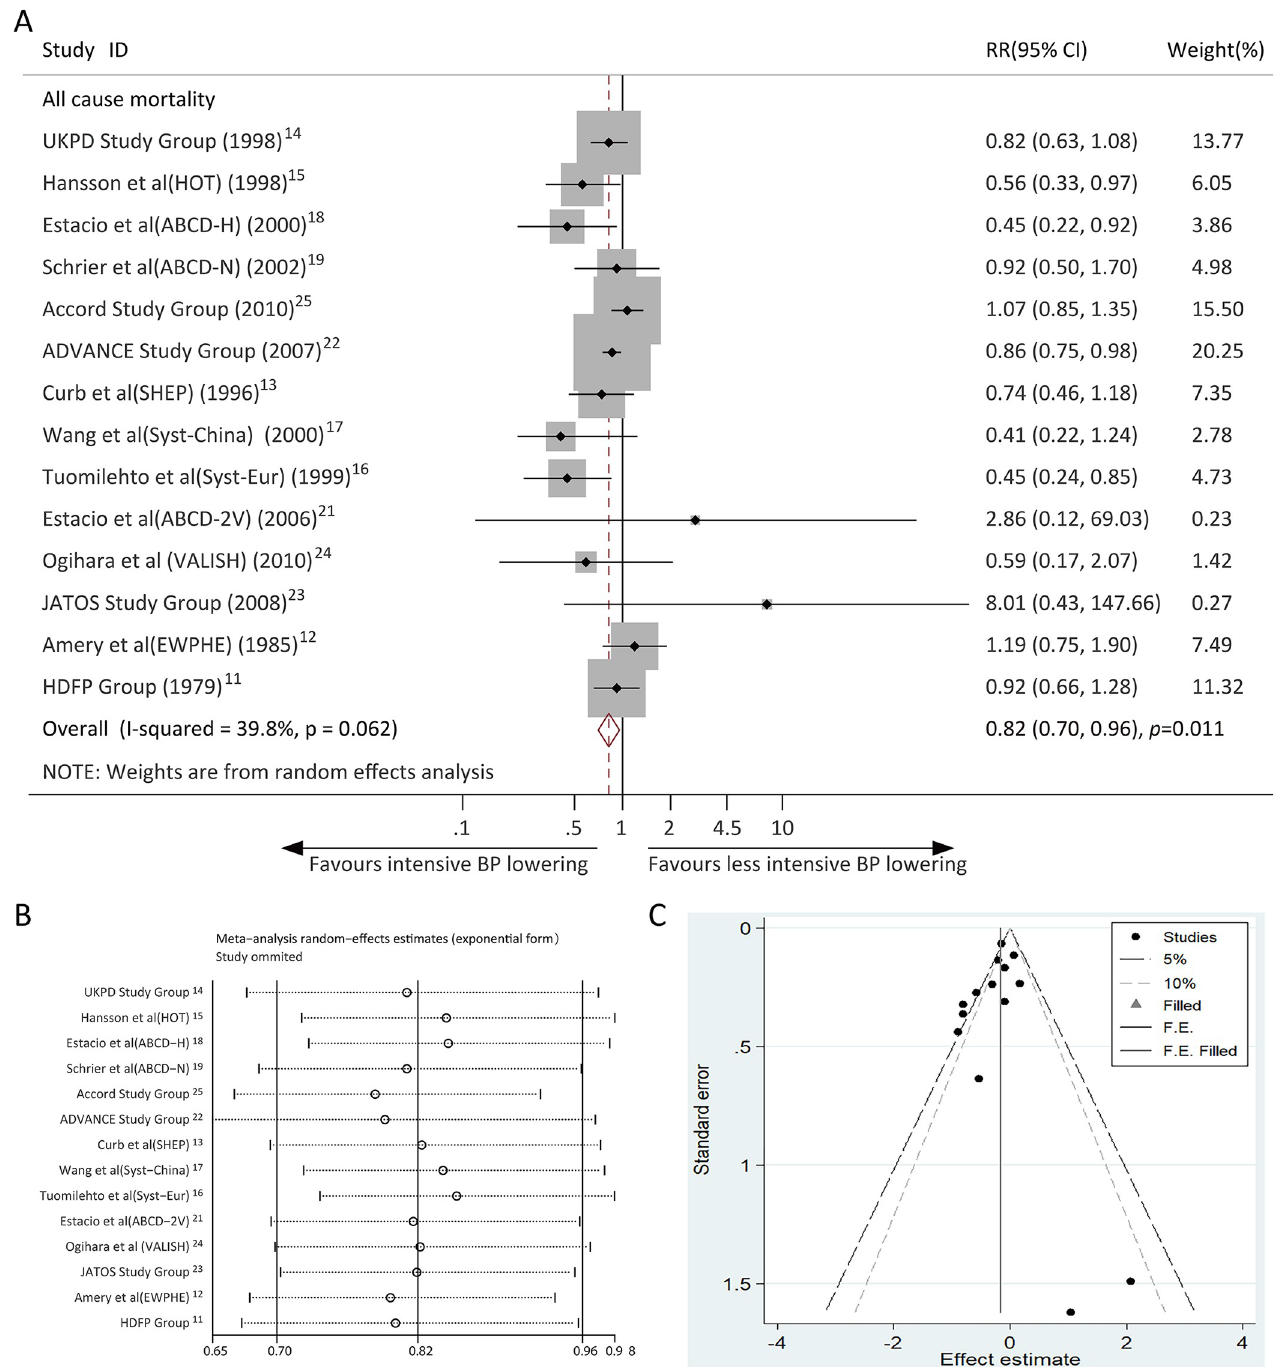
Fig 2. (A) Forest plot showing the effects of intensive versus less intensive blood pressure lowering treatment on all-cause mortality; (B) Plot of sensitivity analysis by excluding one study each time and the pooling estimate for the rest of the studies; (C) Funnel plot of publication bias test. outcomes (major CV events, stroke and MI) that may show benefits from intensive BP lower- ing treatment. Our meta-analysis evaluated the effects of intensive BP lowering treatment on not only CV outcomes but also all-cause mortality and renal outcomes. We referred to a